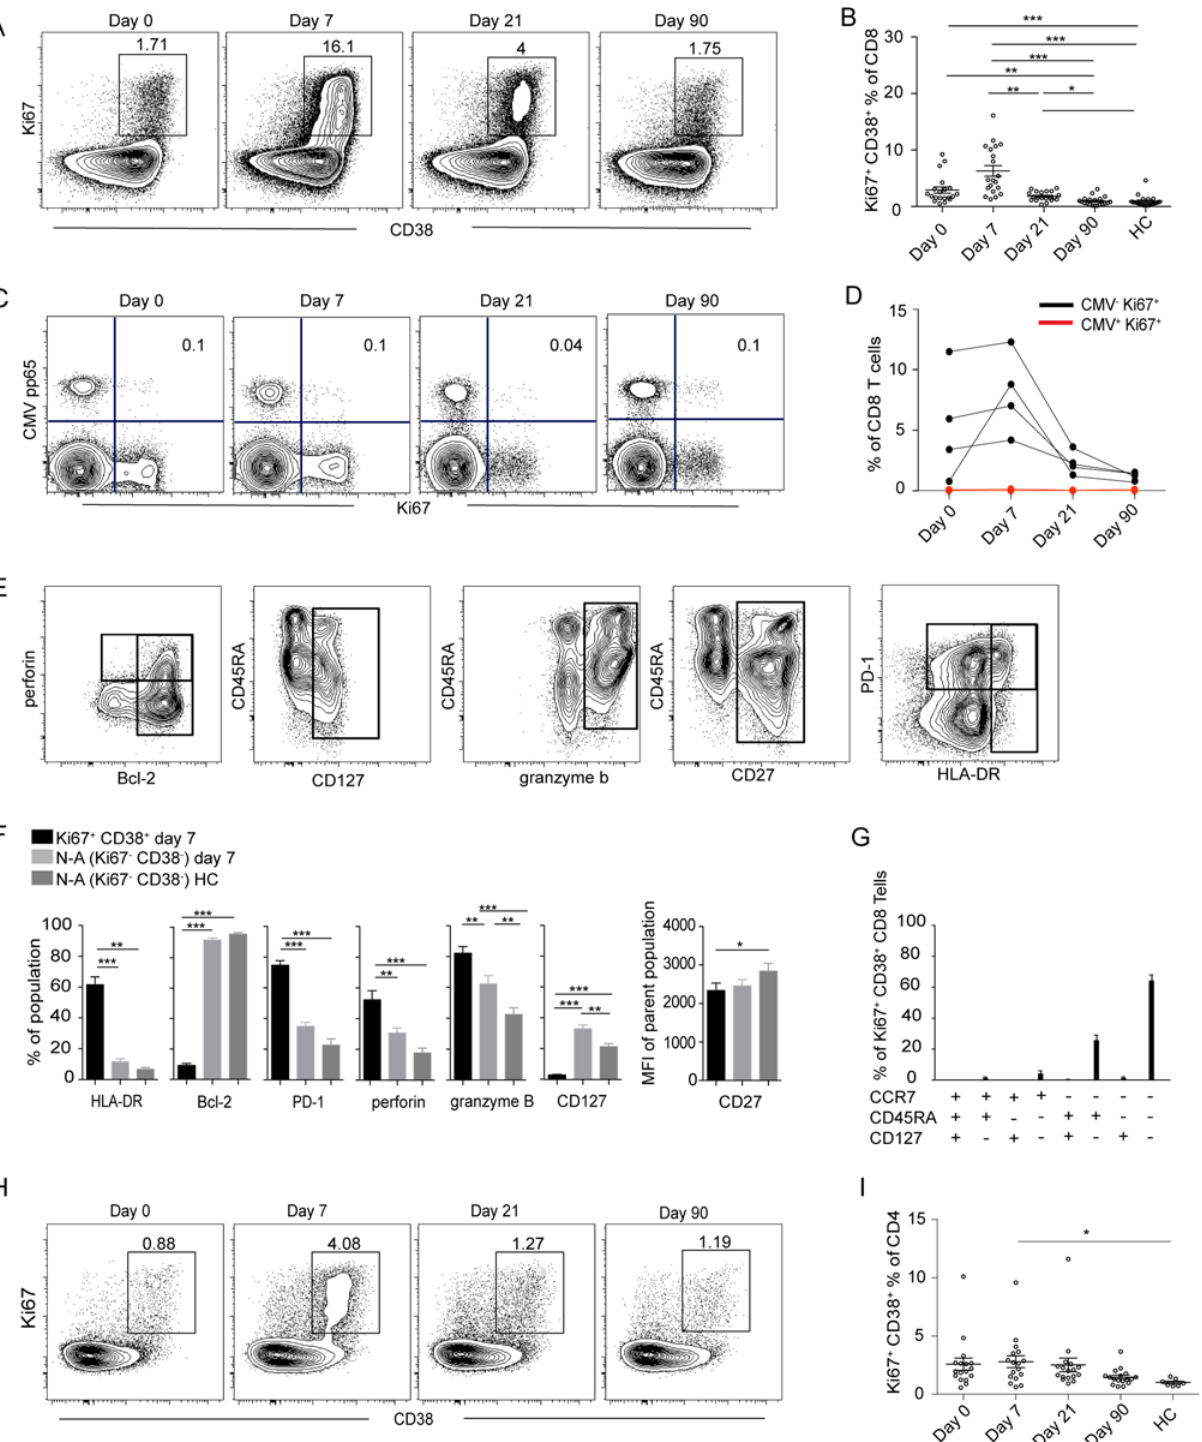
Figure 1. Activation of T cells in the acute phase of TBE infection. (A) CD38 and Ki67 co-expressing cells in the total CD8 T cell population over time in one representative patient. (B) Median and 10 – 90th percentiles of CD38 and Ki67 co-expression in CD8 T cell subsets at day 0, 7, 21 and 90 after hospitalization in infected subjects (n = 20) and in healthy controls (n = 20). (C) Ki67 expression vs CMV-pp65 HLA MHC class I tetramer staining over time in one donor. Percent Ki67 + CMV pp65 + cells are indicated in the plot. (D) Kinetics of Ki67 expression in CMV + (red line) and CMV − (black line) CD8 T cells in four donors over time. (E) Stainings of perforin, CD45RA, PD-1, Bcl-2, CD127, granzyme B, CD27 and HLA-DR at day 7 after hospitalization. Gated on total